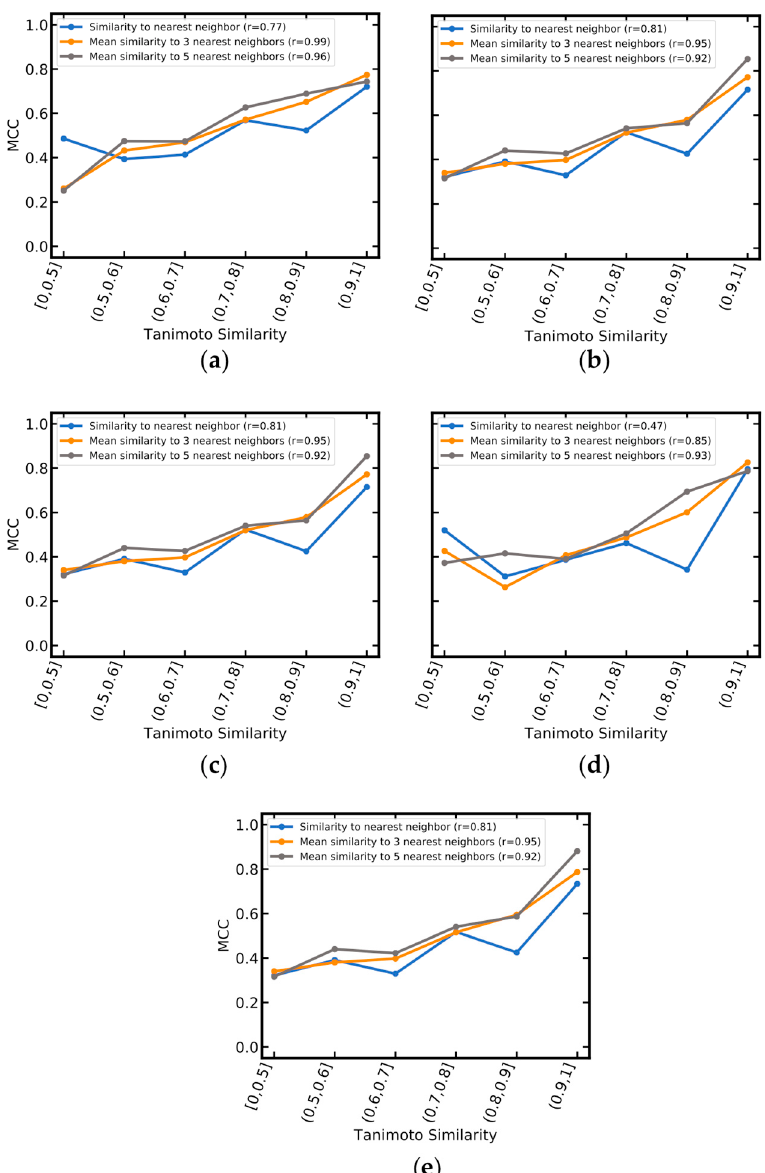
Figure 6. Matthews correlation coe ffi cient (MCC) as a function of molecular similarity between the query compounds and the one, three and five nearest neighbors in the training data (calculated as averaged Tanimoto coe ffi cients based on MACCS fingerprints). correlation coe ffi cients are reported in brackets in the figure legends. The number of compounds in each bin is summarized in Table